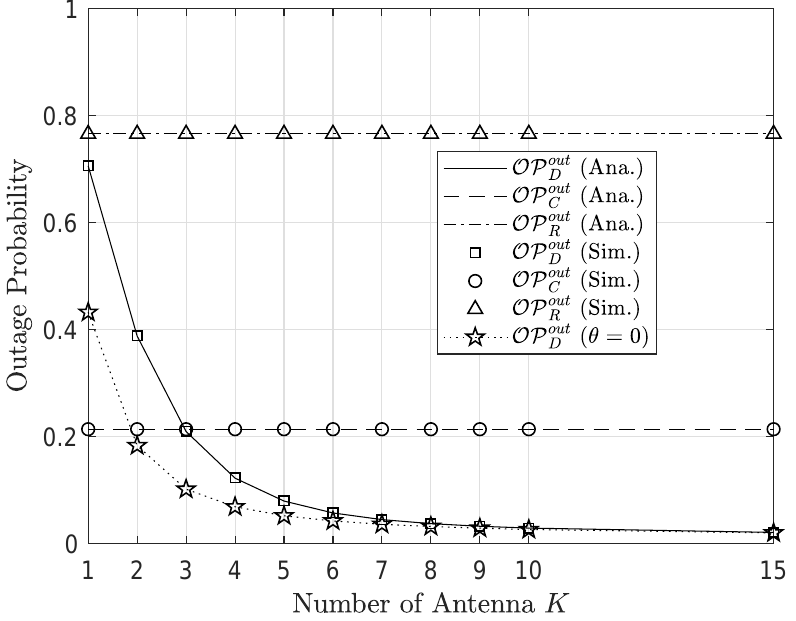
Figure 10. Outage probability versus the number of antenna K